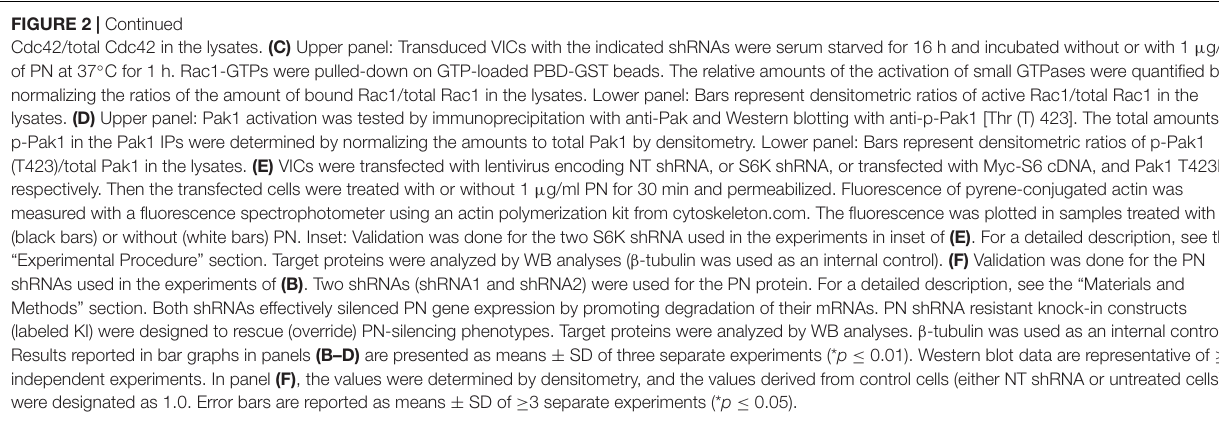
and white bars of lane